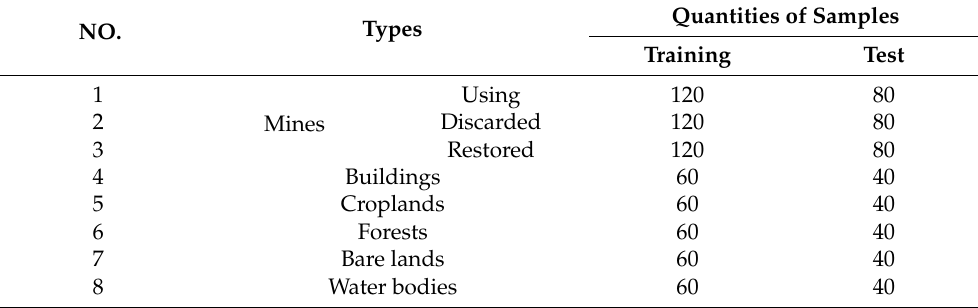
Table 6. Quantities of